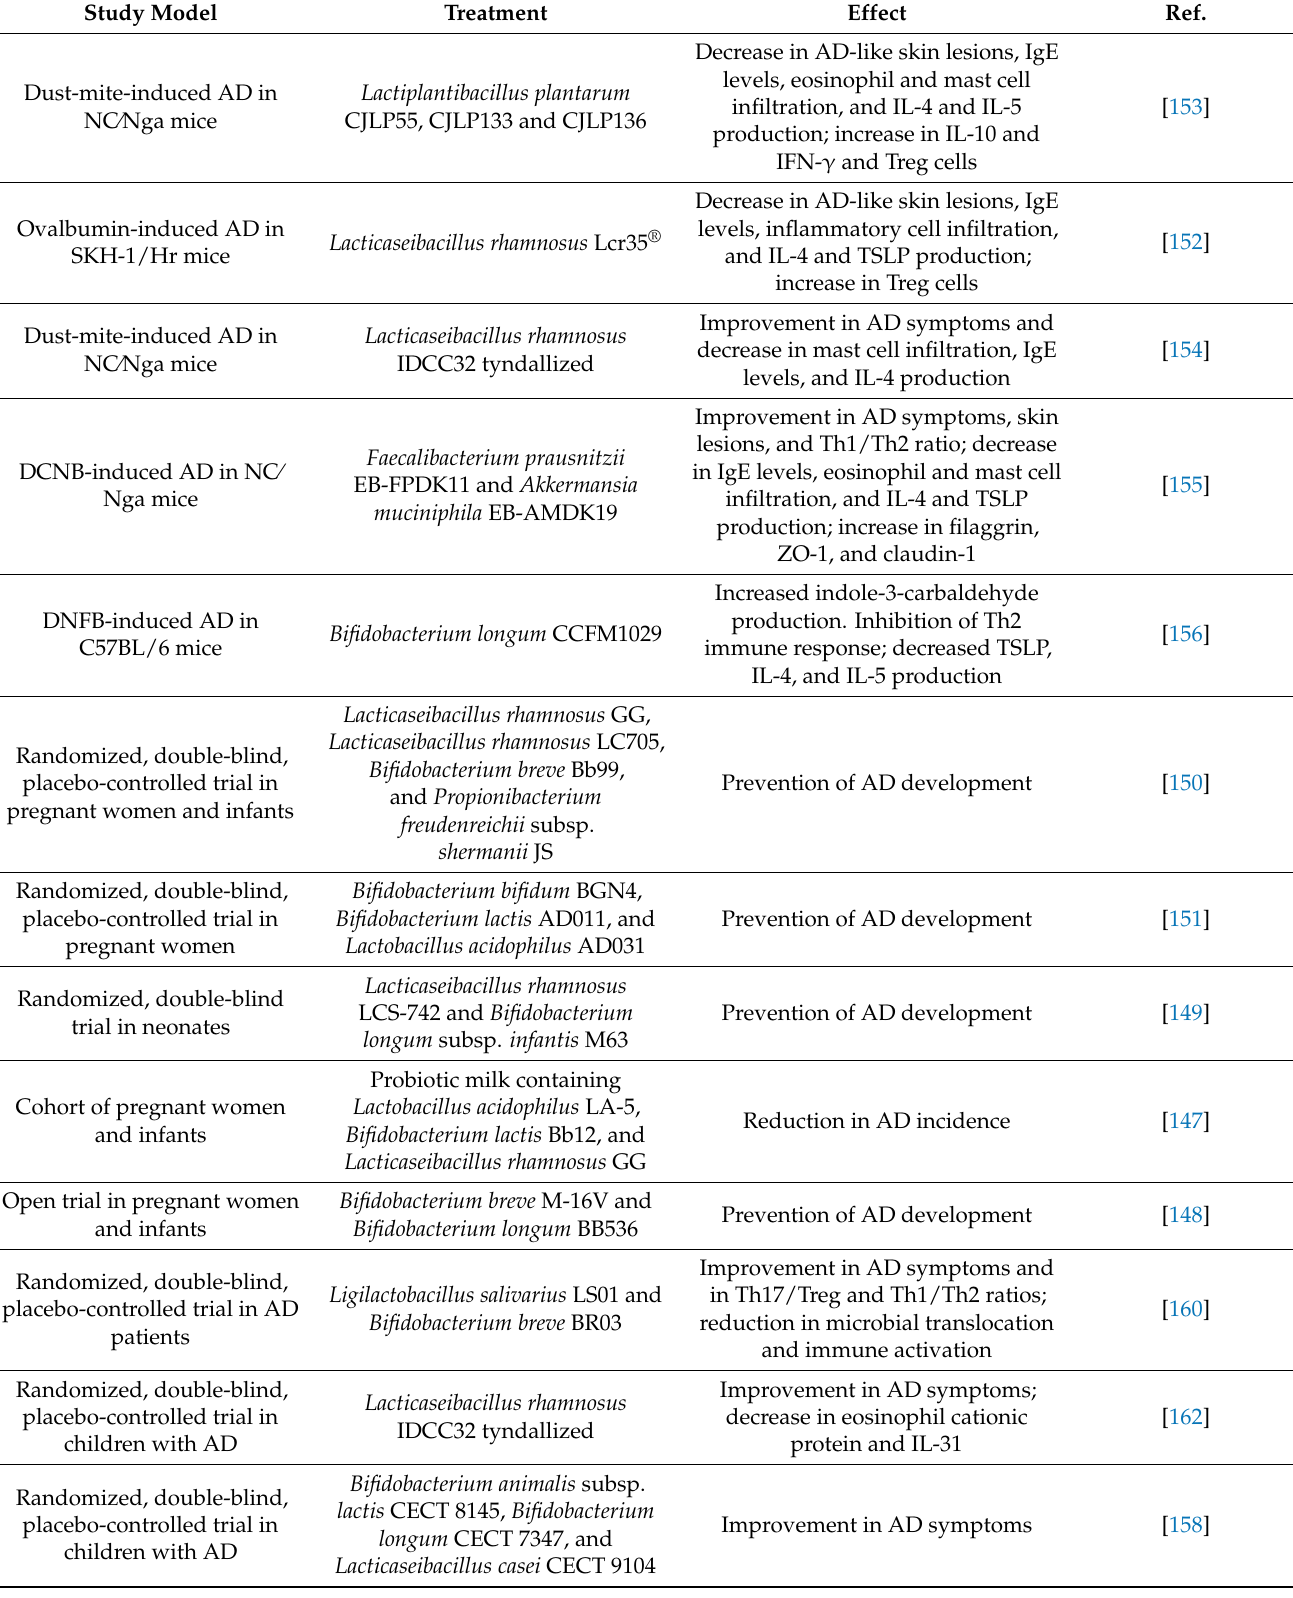
Table 2. Murine models and clinical trials on the use of probiotics in